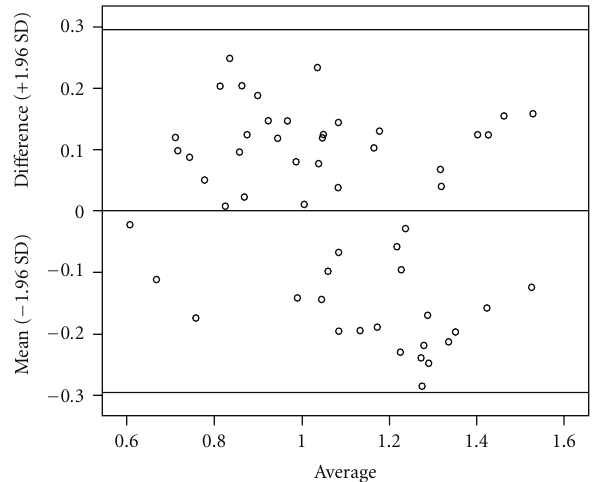
Figure 4: Bland-Altman di ff erence plot by OFM and Doppler ultra- sound